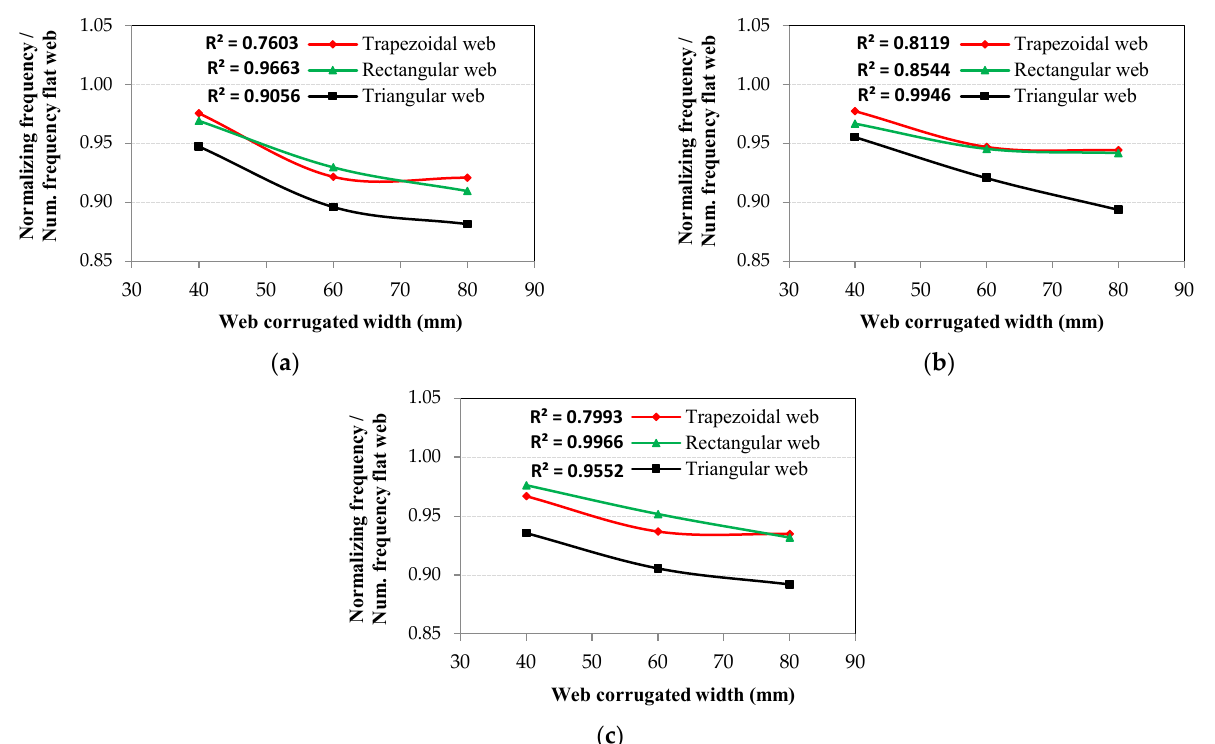
Figure 23. The relationship between normalized frequencies and corrugated web width: ( a ) frequency at the 1st mode shape, ( b ) frequency at the 2nd mode shape, and ( c ) frequency at the 3rd mode